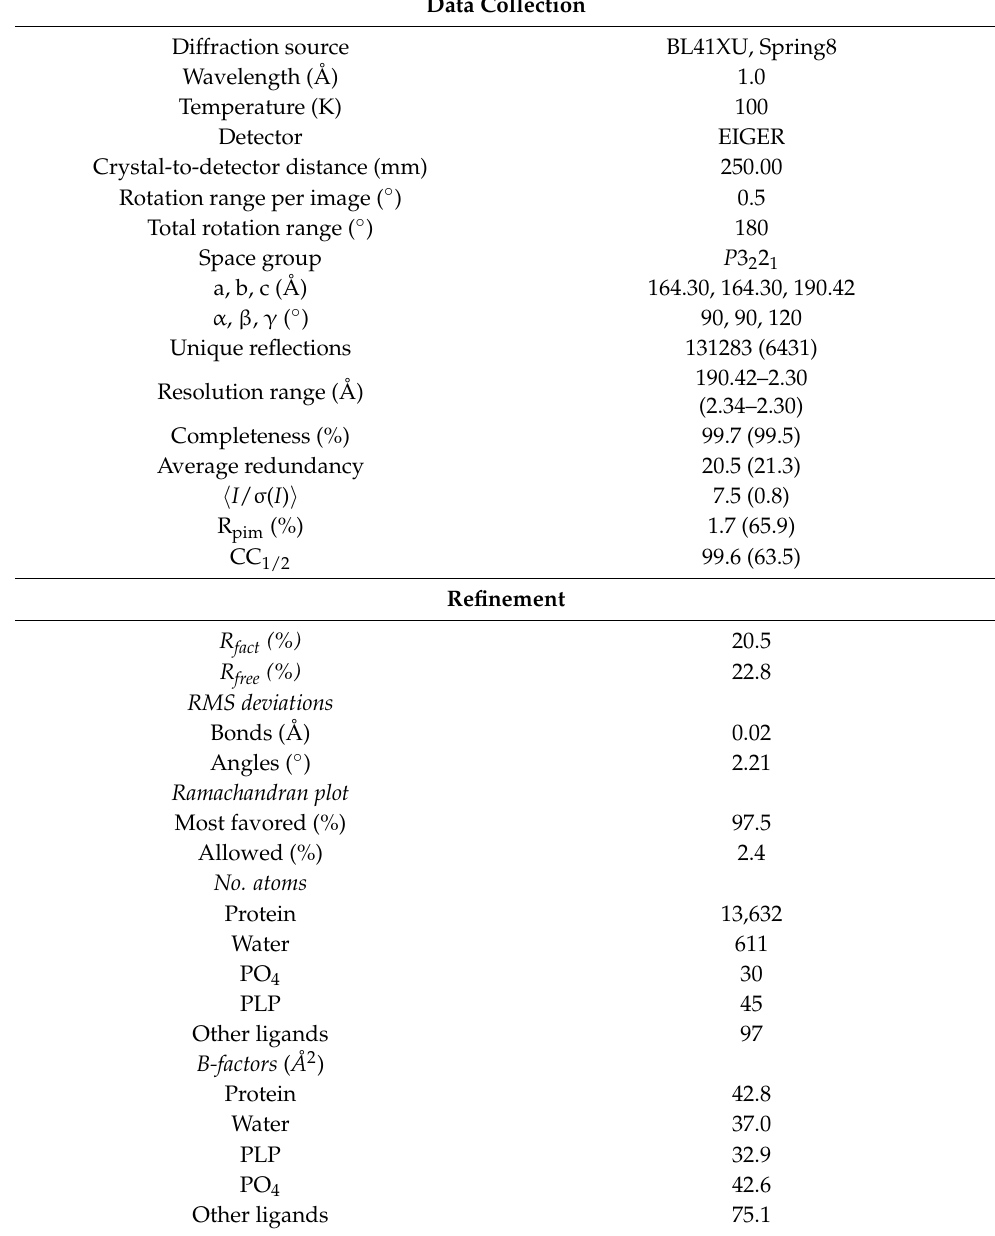
Table 1. Data collection, processing and